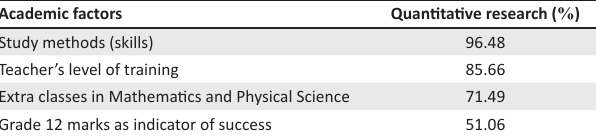
TABLE 1: Quantitative responses related to academic